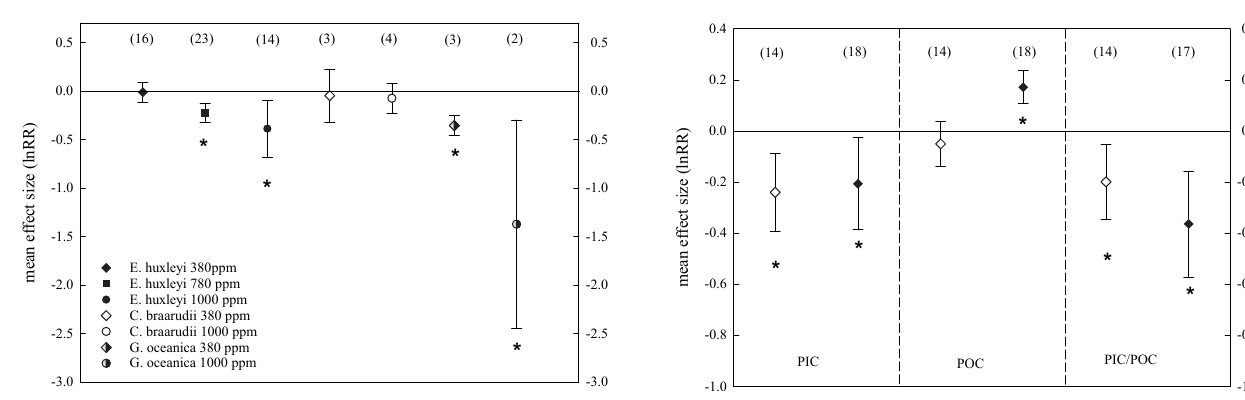
Figure 4. Comparison of effect sizes between the methods of car- bonate chemistry manipulation. White diamonds symbolize treat- ments where total alkalinity (TA) was kept constant while dissolved inorganic carbon (DIC) changed. Black diamonds symbolize treat- ments where DIC was kept constant and TA varied. The number of experiments included in the meta-analysis are shown in parenthe- ses. The mean effect size is significant when the 95% confidence interval does not overlap zero